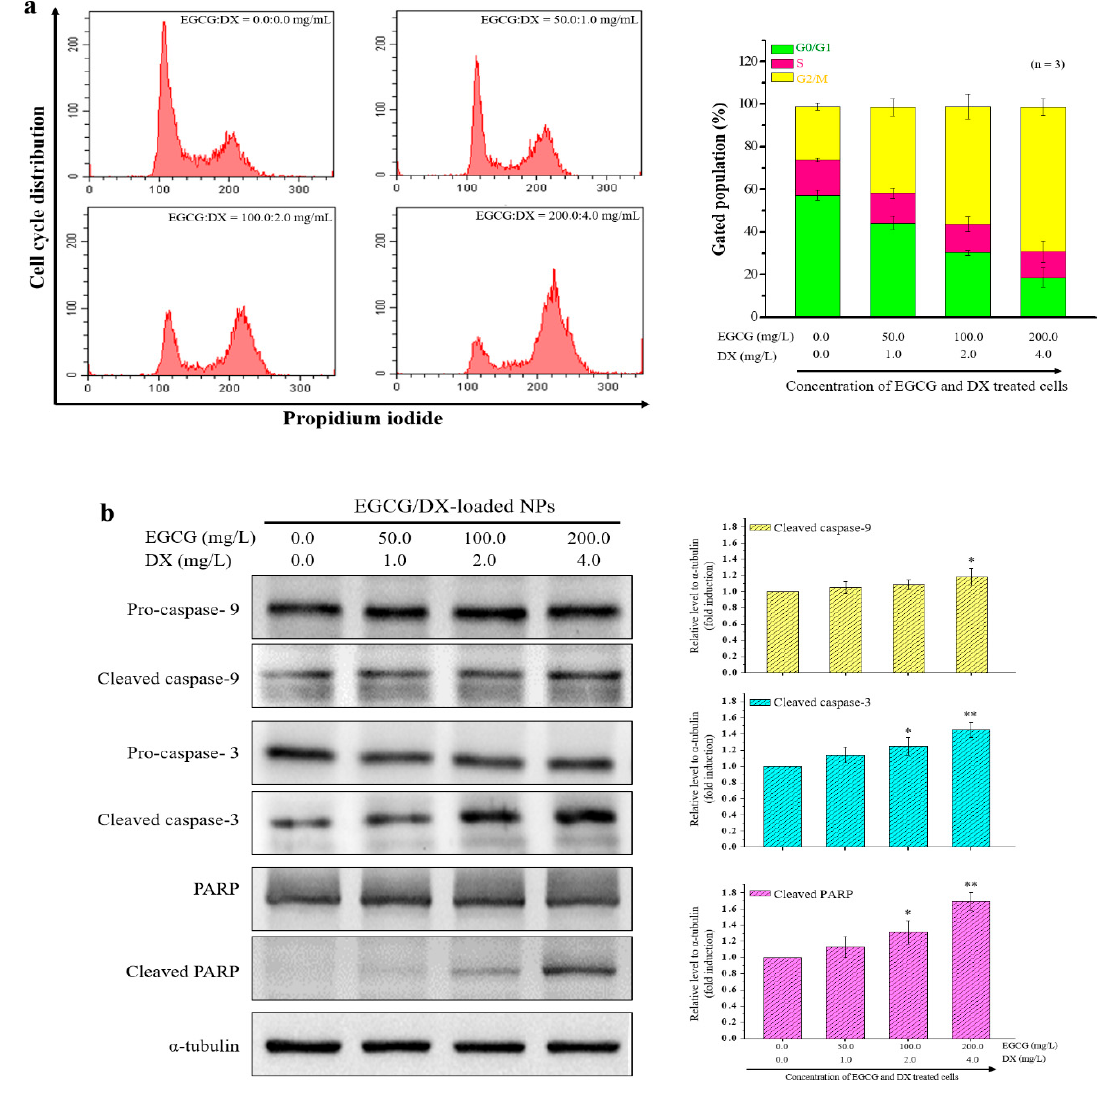
Figure 6. ( a ) The proportions of cells in the G0/G1, S, and G2/M phases, after treatment with EGCG/DX-loaded FD/TH/PG NPs are indicated. The cells were stained with propidium iodide and the cell cycle distribution was analyzed using flow cytometry. ( b ) Western blotting analysis of apoptosis-related caspase-9, caspase-3, and PARP in MKN45 cells after incubation with EGCG/DX-loaded FD/TH/PG NPs and α -tubulin was used as an internal control. * Statistically significant difference of p < 0.05 and ** p < 0.01, respectively as compared with the without sample treatment group.